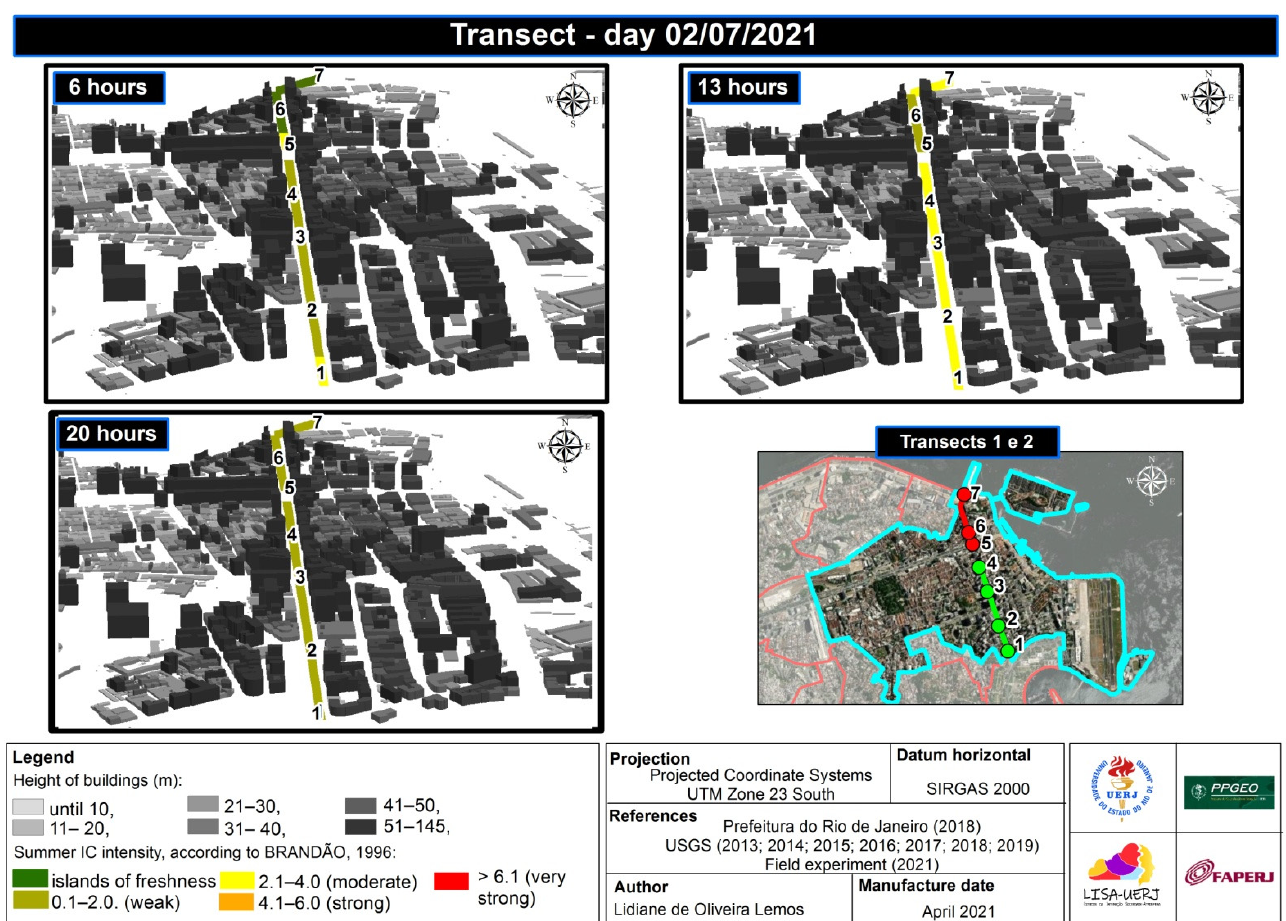
Figure 14. Rio de Janeiro—horizontal thermal field, in the urban canyon of Rio Branco Avenue, on 7 February (Sunday).